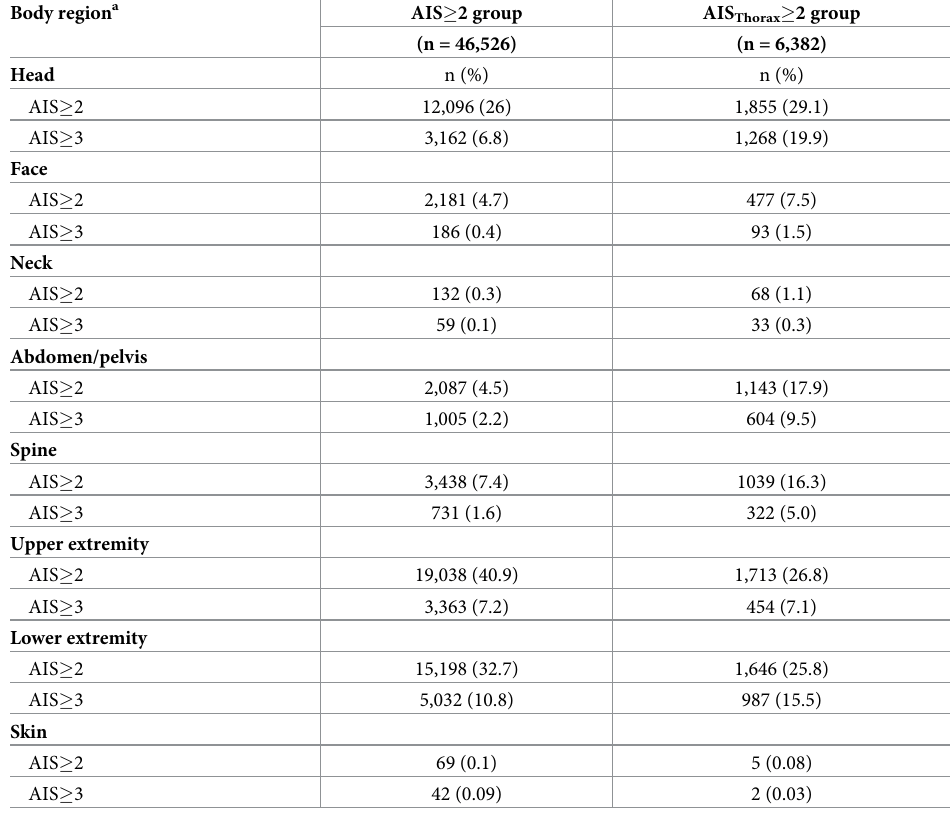
Table 3. Concomitant extra-thoracic injuries between AIS Thorax � 2 group and AIS Thorax < 2